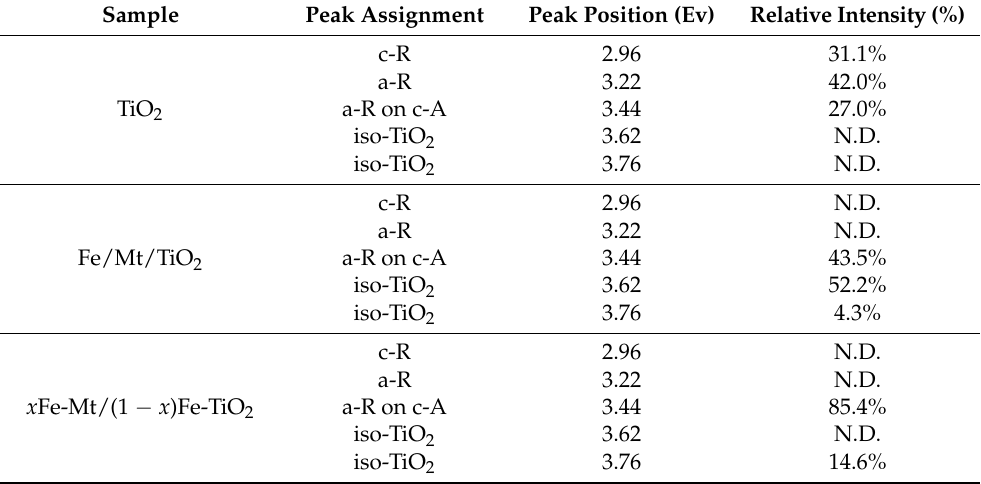
Table 2. Parameters of ERDT peak fitting of Fe/Mt/TiO 2 and x Fe-Mt/(1 − x )Fe-TiO 2 . c-R, a-R, a-R on c-A, and iso-TiO 2 are the abbreviation of crystal rutile, amorphous rutile, amorphous rutile covered on crystal anatase, and isolated amorphous TiO 2 ,